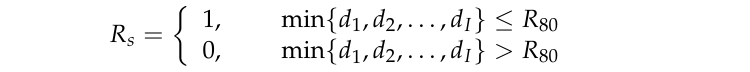
Figure 3. Roadside data collection system. 3.2. Data Processing 3.2.1. Raw Data Processing Taking the position of the microwave detector as the base point, the raw trace file included the traffic flow data in both directions towards and away from the base point. In the observation coordinate system of the microwave detector, the longitudinal speed of the vehicle far from the detector was defined as positive, while that of the vehicle close to the detector was defined as negative. Since this study only focused on the traffic safety conditions in the diversion area (near the off-ramp), the longitudinal speed of the point trace was used to distinguish traffic flow in two directions, and all traffic data from vehicles leaving the base point was excluded. The scattered point traces were converted